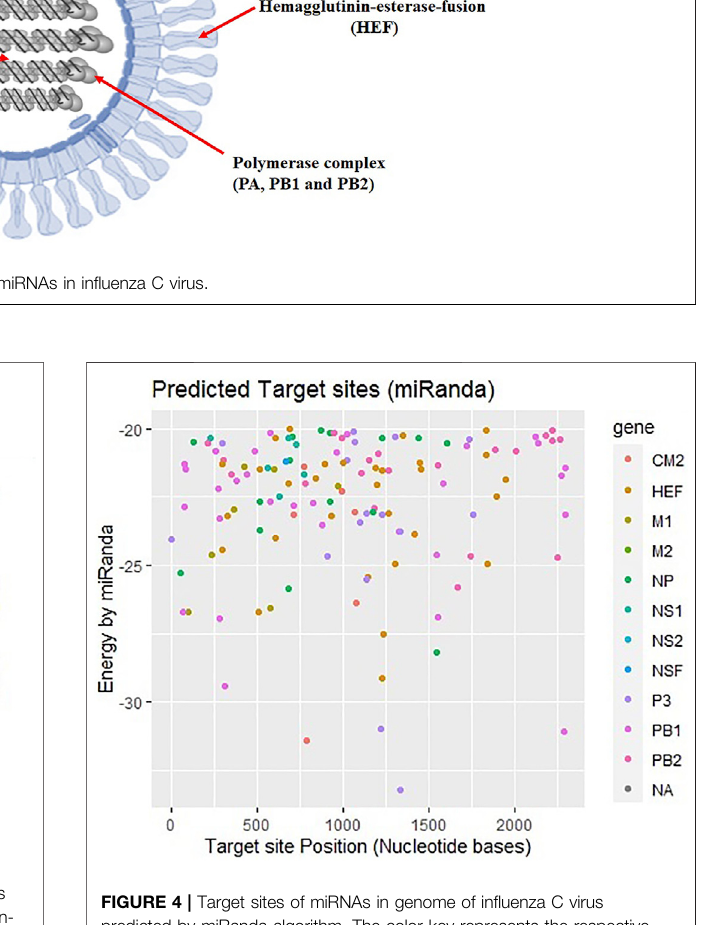
FIGURE 4 | Target sites of miRNAs in genome of in fl uenza C virus predicted by miRanda algorithm. The color key represents the respective genes/proteins in the graph. The gray dots labeled as NA which indicate non-